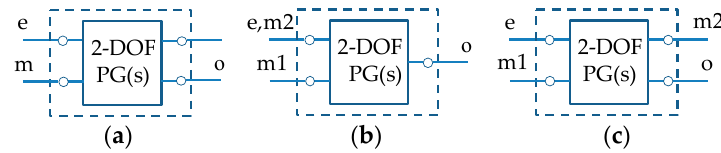
Figure 7. Typical 2—DOF PG(s) system: ( a ) three-port device with three PC; ( b ) three-port device with four PC; ( c ) four-port device with four PC. (PC—powertrain components; PG—planetary gear.)